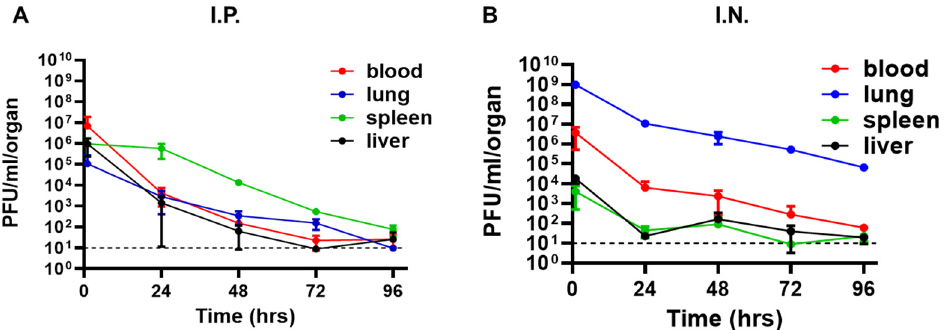
Figure 5. Pharmacokinetic analysis of PST in naive mice. A single dose of PST phage suspension (1 × 109 PFU) was administered to naive C57BL/6J mice, either by ( A ) IP injection (0.5 mL) or ( B ) via the IN route (35 µ L). For each administration route, n = 3 for each time point. Phage titration was performed using a spot assay test. Each dot represents the mean value in terms of PFU/organ (lung—blue dots, spleen—green dots, liver—black dots) or PFU/mL blood (red dots). Bars represent the standard deviations (SDs).